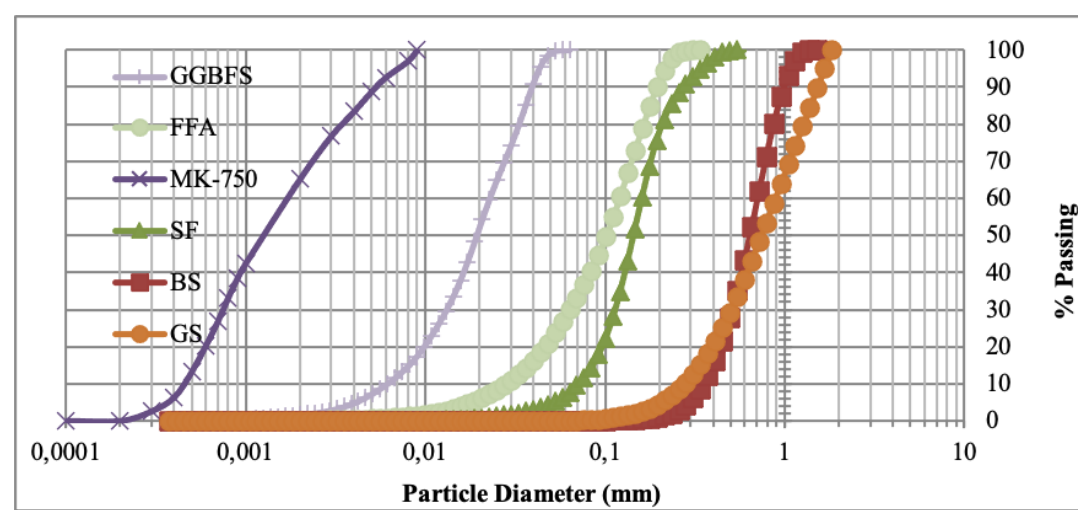
Table 1. Properties of Steel Fibres.